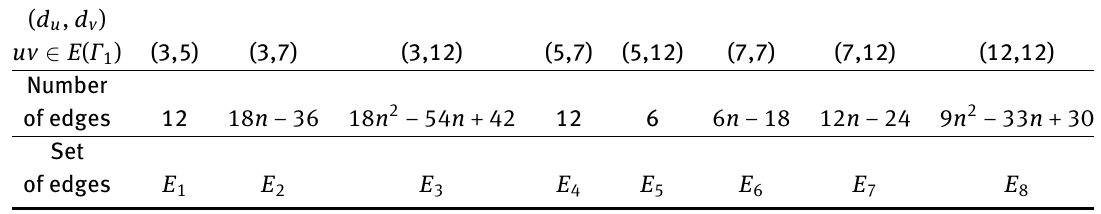
Table 2: Vertex degree based edge partitioning of a graph Γ 1